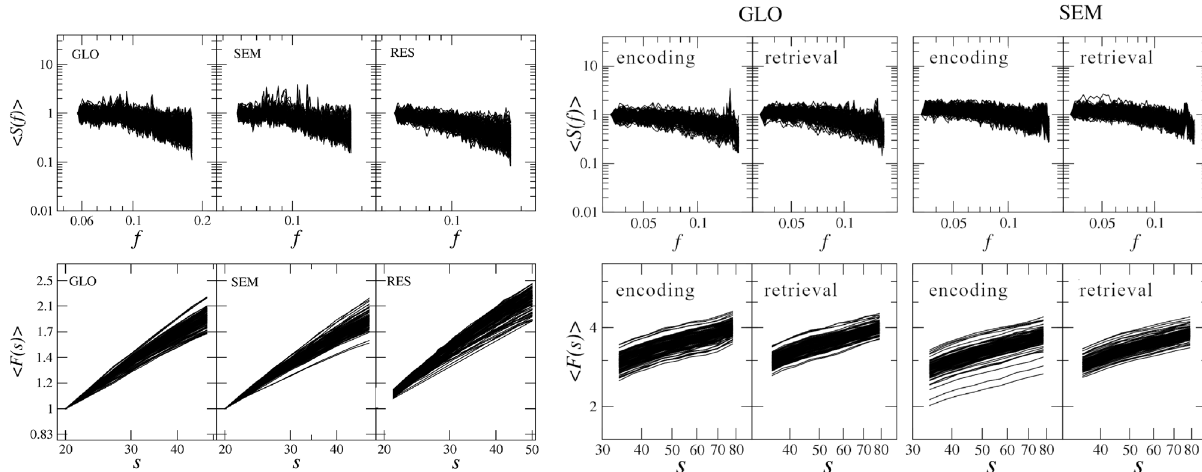
S ( f ) F ( s ) and fluctuation functions, , estimated for two tasks (verbal semantic, (cid:31) (cid:30) (cid:31) (cid:30)